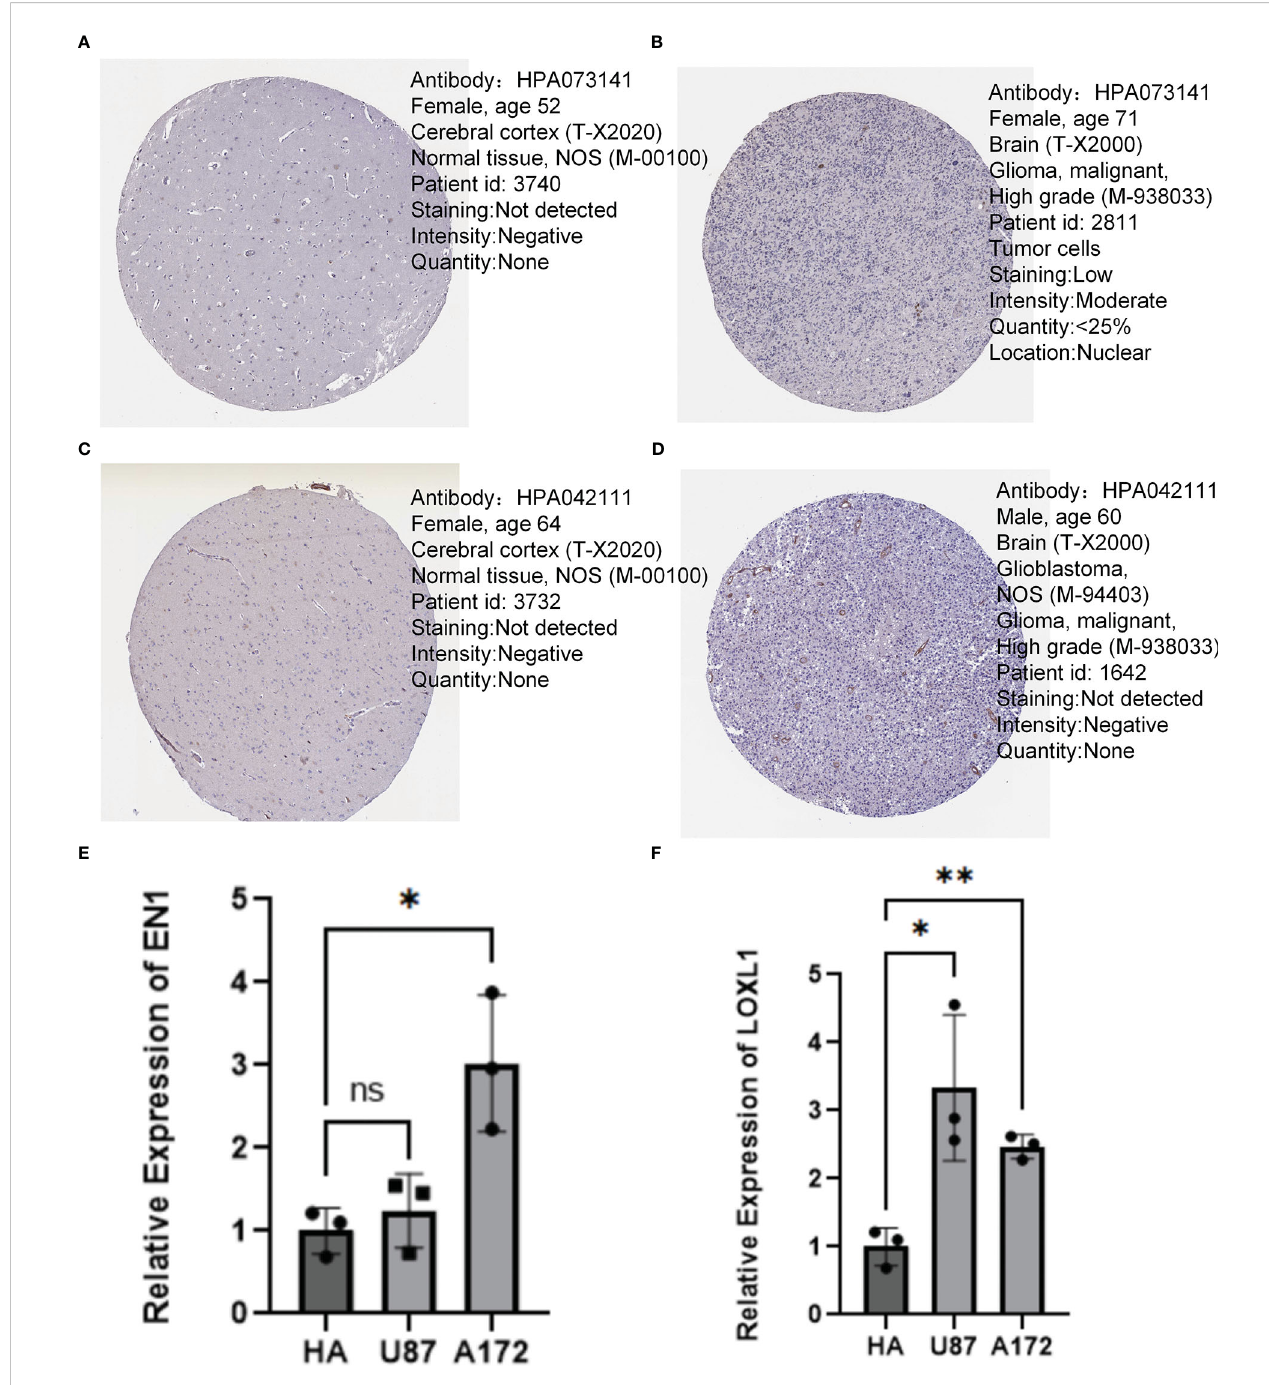
FIGURE 11 Immunohistochemistry and QT-PCR. (A, B) Protein expression levels of EN1 in normal cerebral cortex and GBM. (C, D) Protein expression levels of LOXL1 in normal cerebral cortex and GBM. (E) RT q-PCR analysis of EN1 expression in various types of glioma cells. (F) RT q-PCR analysis of LOXL1 expression in various types of glioma cells. *p < 0.05, **p < 0.01, ***p < 0.001, ns, no signi fi